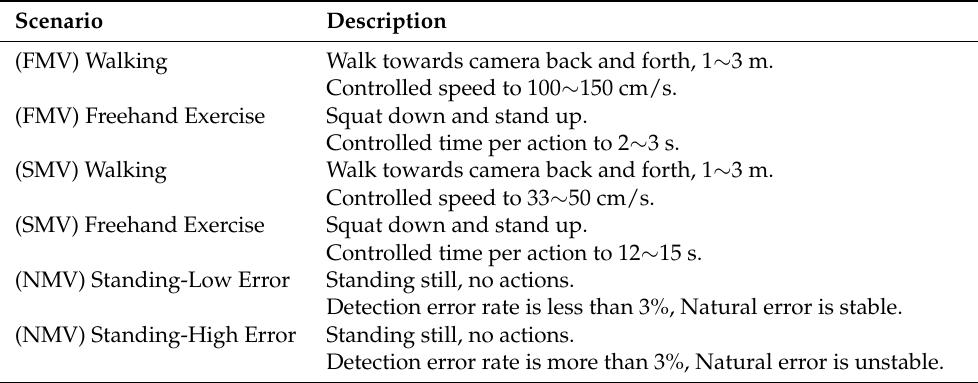
Table 2. Scenario list. Each have 15 video